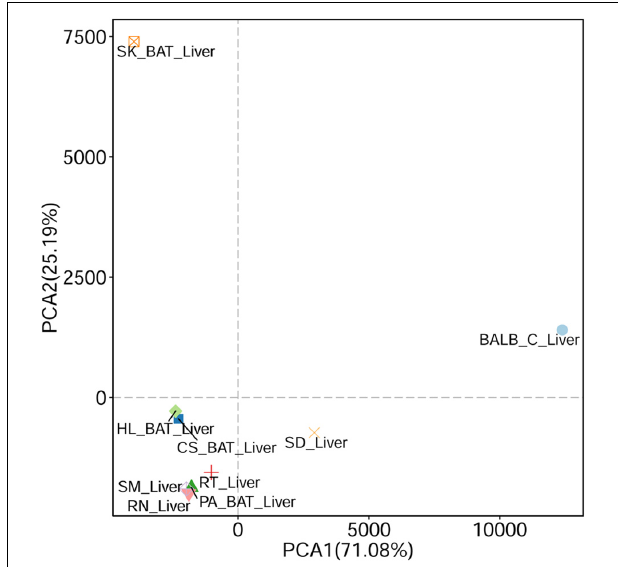
FIGURE 2 | Principal component analysis (PCA) (based on Euclidean distance) plots between liver tissue samples from different animals.